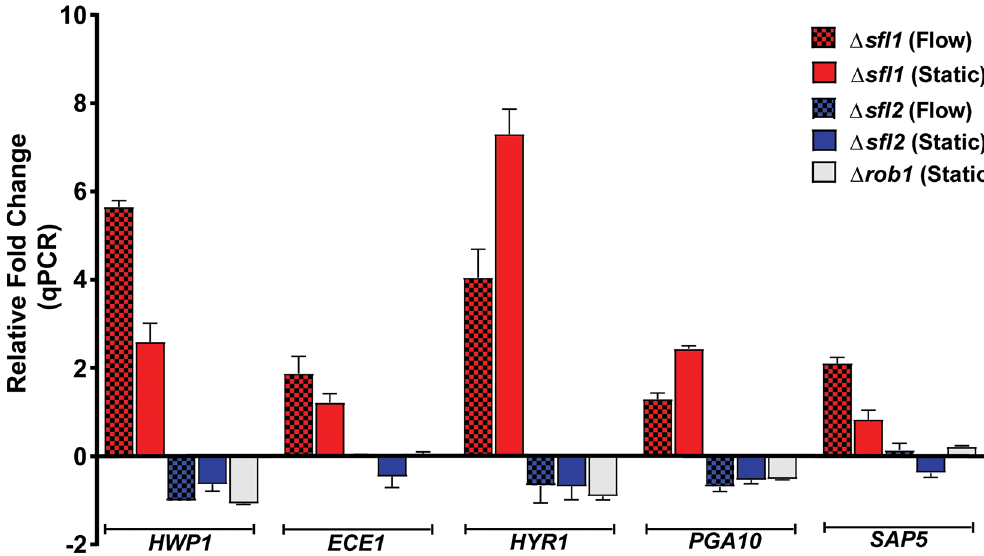
Fig 6. Quantitative real-time RT-PCR analysis of core microcolony genes under flow and static conditions. Expression of the core microcolony genes HWP1 , ECE1 , HYR1 , PGA10 and SAP5 was quantified by qRT-PCR experiments in Δ sfl1 , Δ sfl2 and Δ rob1 strains grown under flow and static conditions at 37˚C. Expression of the core microcolony genes were highly up- regulated in Δ sfl1 cells (flow indicated by red hatched bars, static by red solid bars), and down-regulated in both Δ sfl2 (flow indicated by blue hatched bars, static by blue solid bars) and Δ rob1 (static white bars) microcolonies. Bars in each graph indicate relative fold changes in RNA expression of each sample as compared to control actin. The results represent the averages from triplicate samples from two independent experiments. The error bars indicate standard